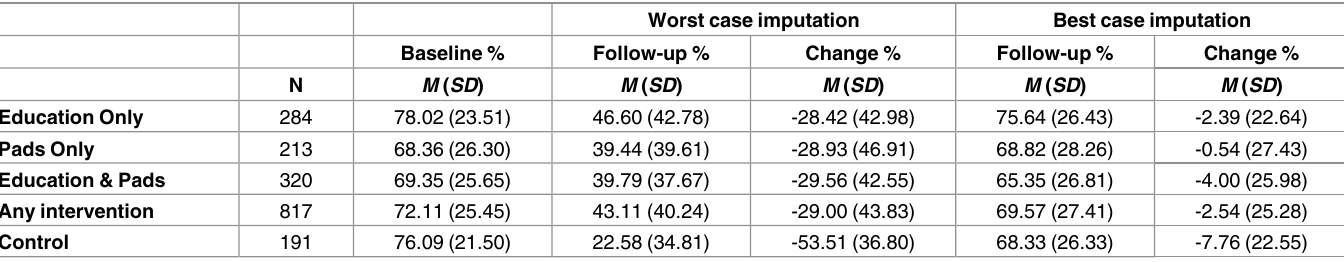
Table 4. Mean percentage attendance at baseline, follow-up and change scores across conditions for best and worst case imputations (n =